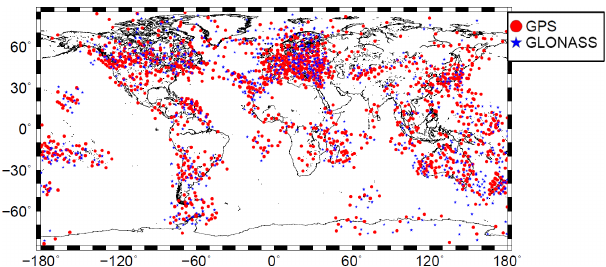
Figure 7. Global distribution of the IPPs from GPS (red dots) and GLONASS (blue stars) measurements for 6 September 2017, at